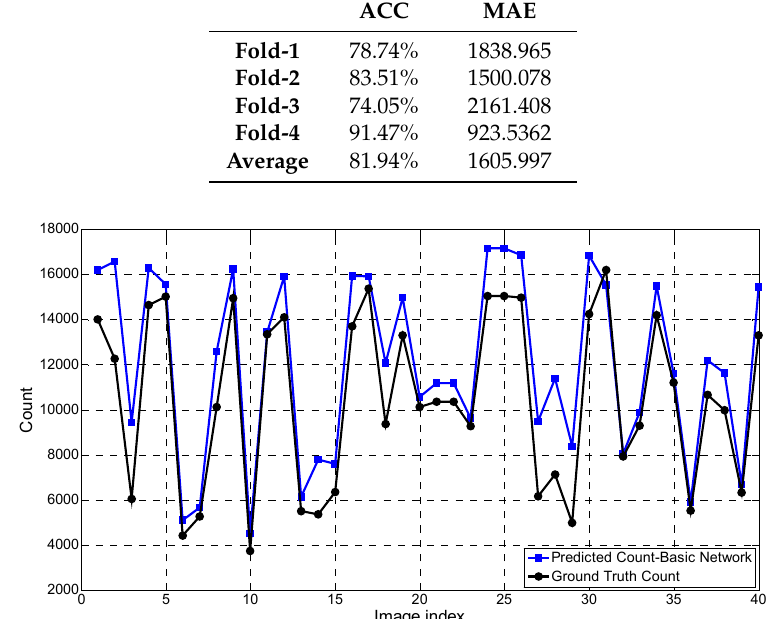
Figure 6. Predicted count obtained from the Basic Network model versus the ground truth count for each of the 40 images in the RSC dataset.